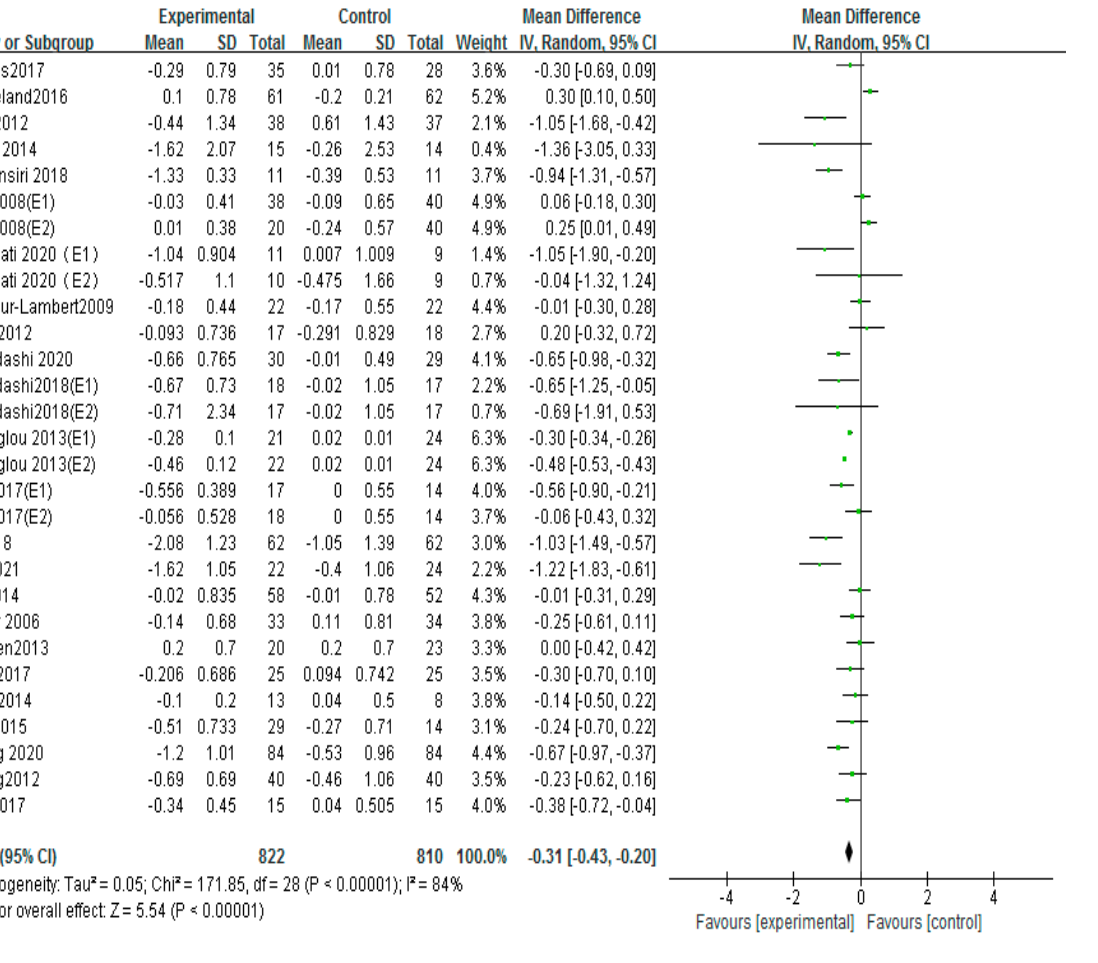
Figure 8. Meta − analyses of the effect of exercise on LDL − C compared with the control group